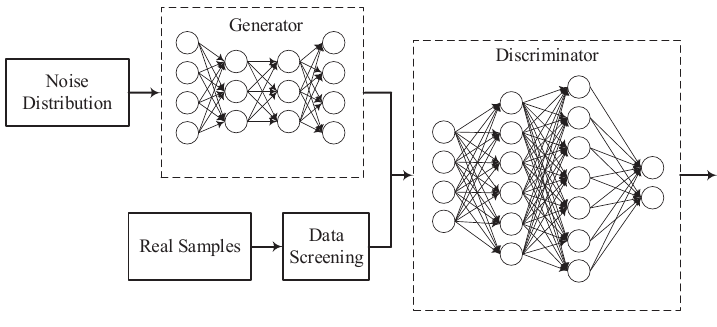
Figure 2. Typical architecture of